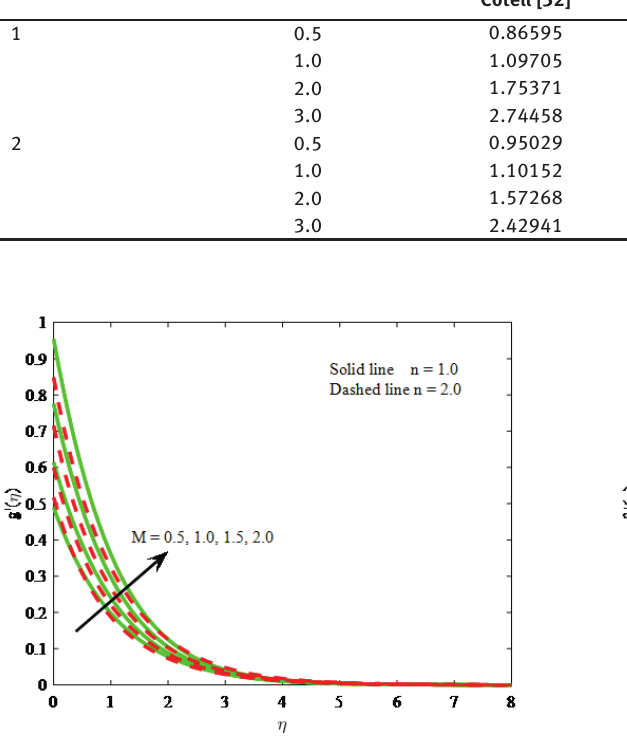
Fig. 3: Impact of M on micro-rotation velocity.